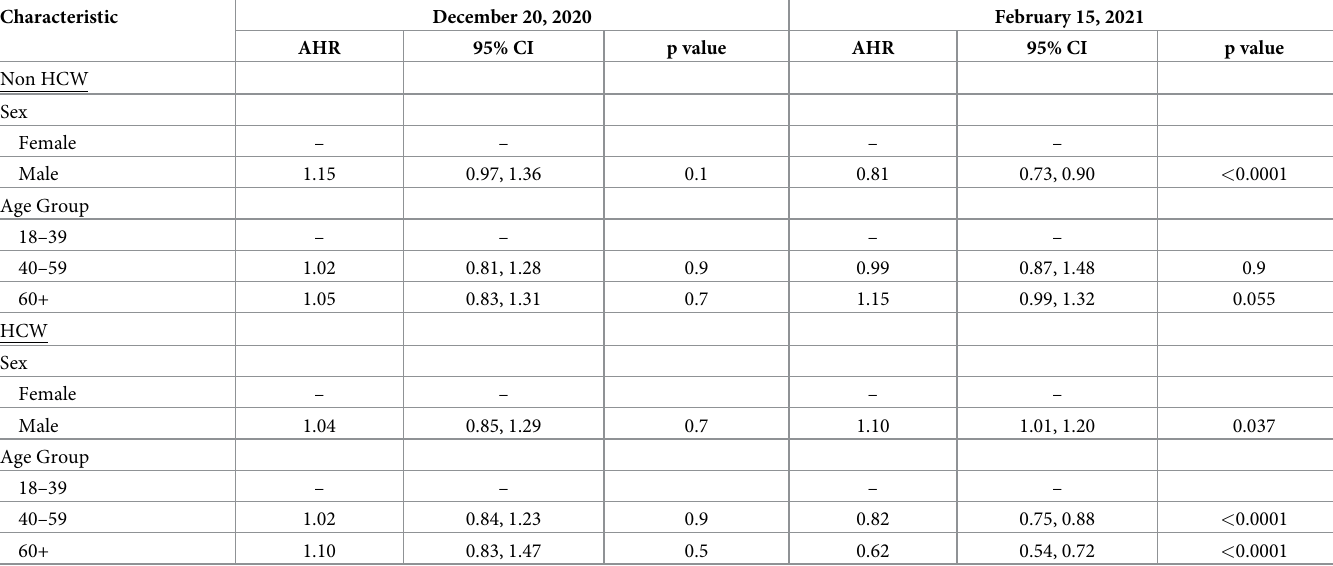
Table 4. Risk of seroconversion within